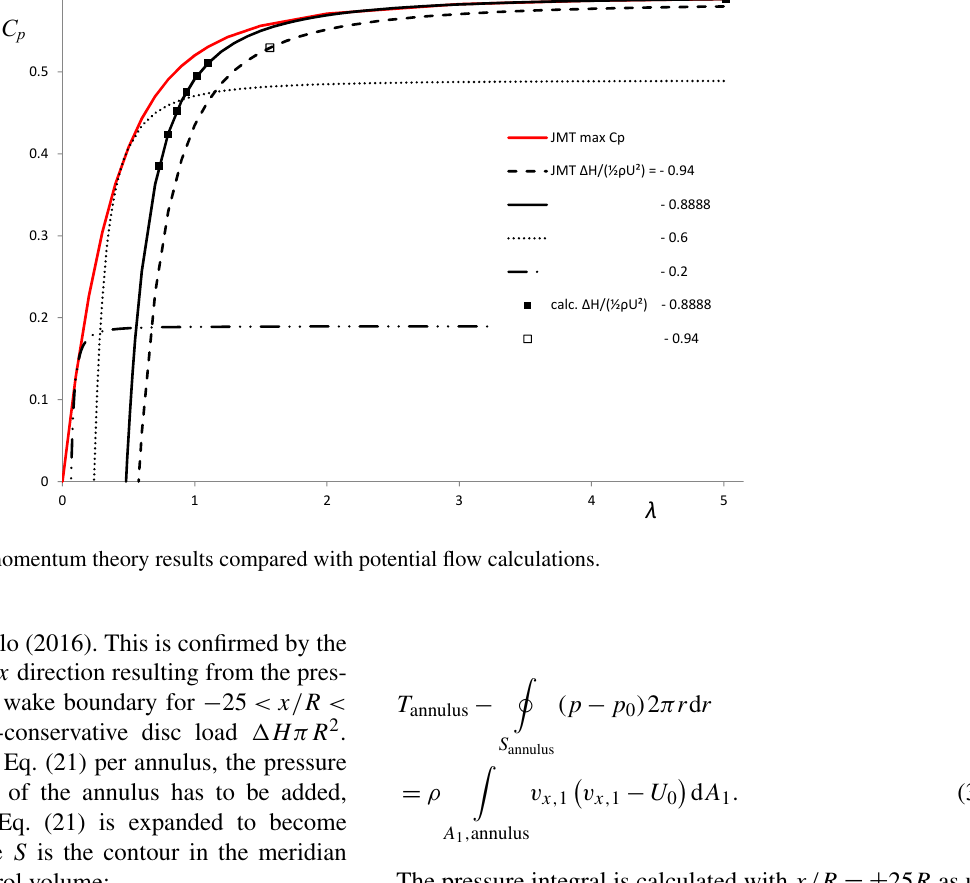
Figure 6. v x at the disc for the load case (cid:49)H/ ( 1 annulus and the result from the momentum balance per annulus. The two annuli lines coincide except in the outboard annulus.